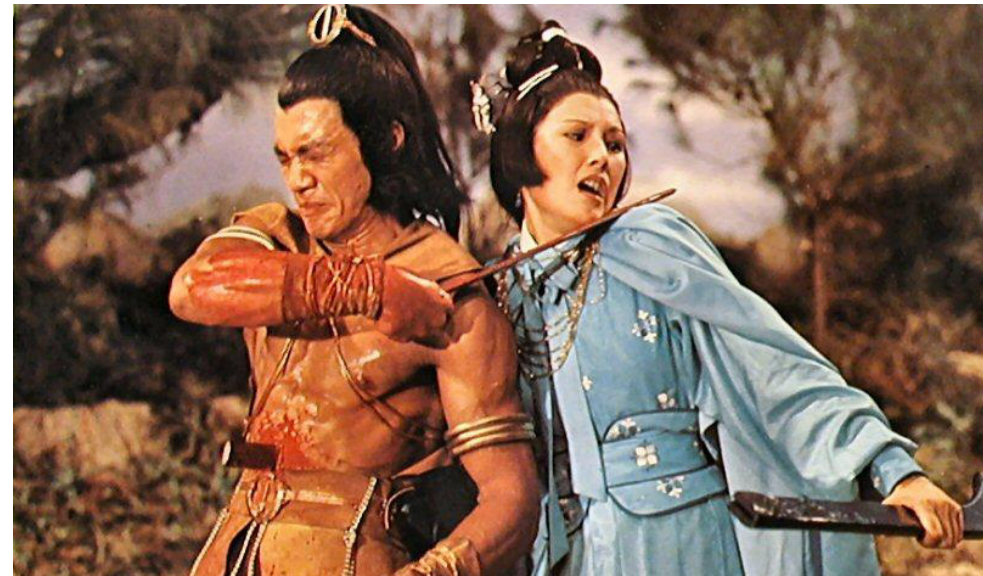
Figure 4. Leng Feng defeating Golden Arm.